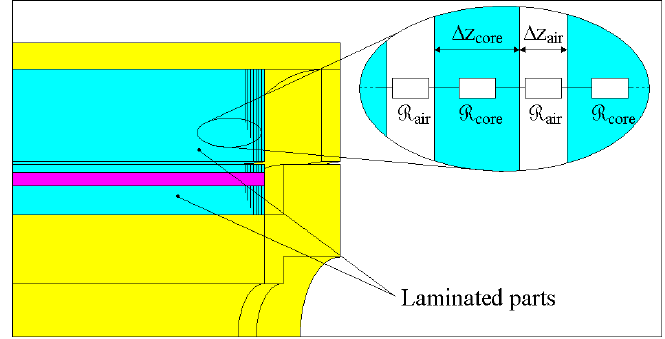
Figure 19. Lamination effect modeling.